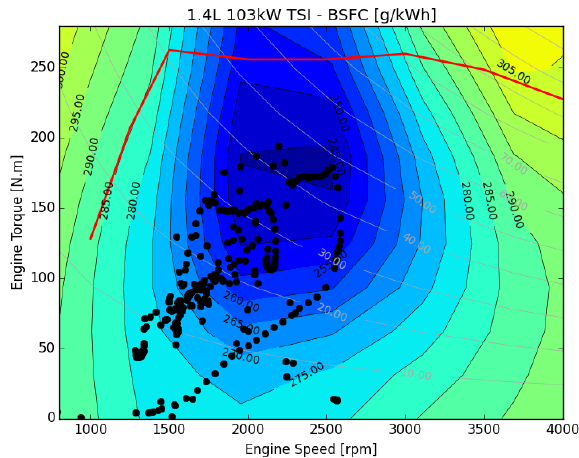
Figure 6. Engine Map